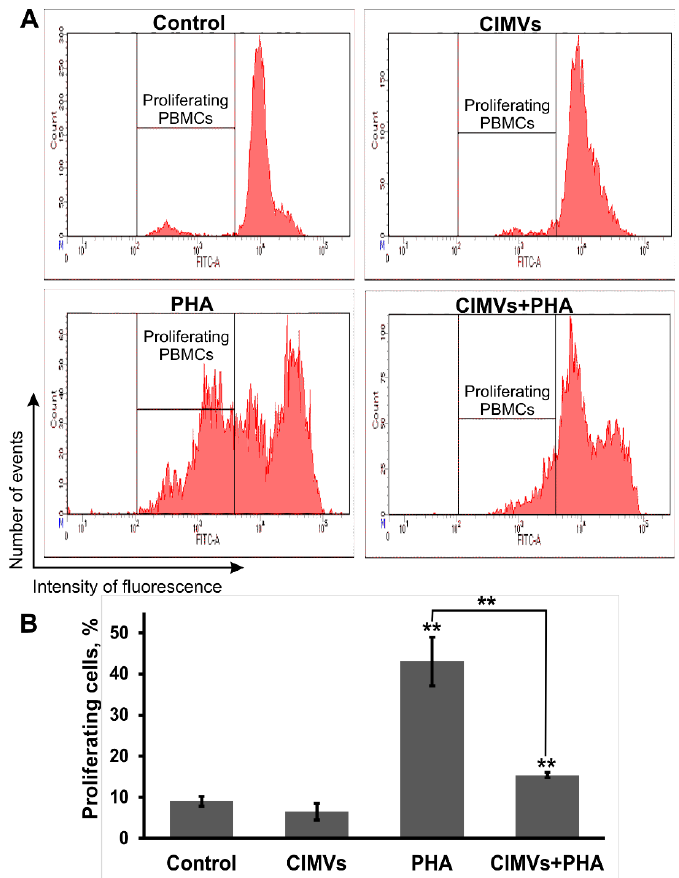
Figure 4. Analysis of phytohemagglutinin (PHA)-induced proliferation of PBMCs. PBMCs were stained with CFDA SE prior to incubation with PHA. Flow cytometry data ( A ). Histograms were generated using FACSDiva7 software (BD Bioscience, USA). The percent of cells with decreased